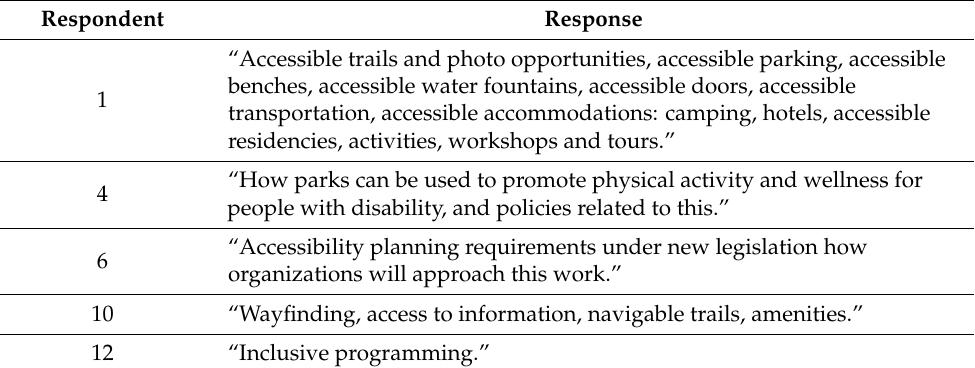
Table 2. Pre-conference survey